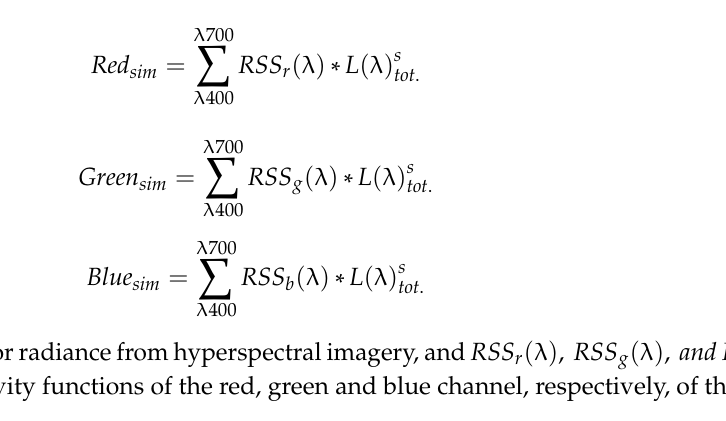
Figure 5. Relative spectral sensitivity function of a Canon 10D digital single-lens reflex camera used to simulate a true-color red-green-blue (RGB) image from the hyperspectral imagery. Red, green and blue bands of the simulated image were produced by convolution products (Equations 2, 3 and 4, respectively):